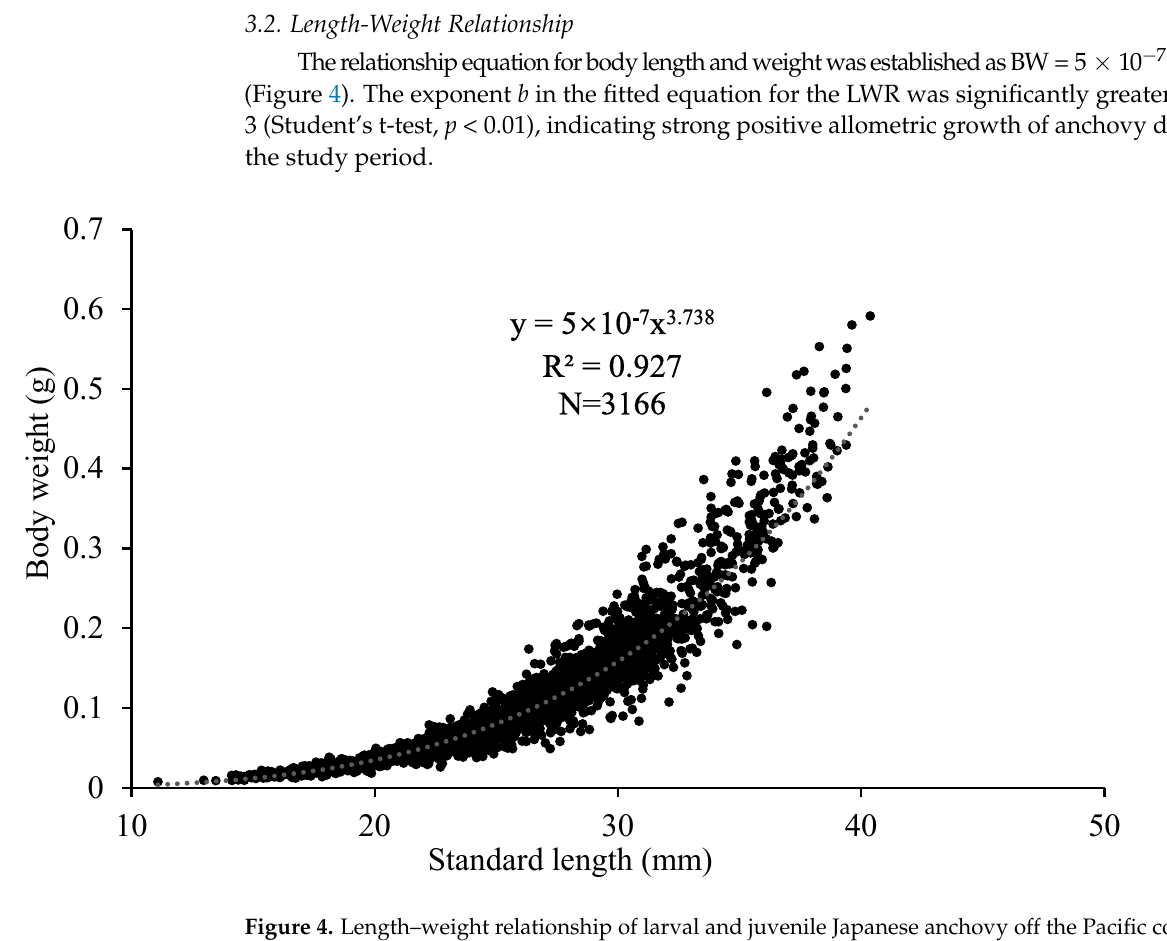
Table 2. The parameter estimates and comparison of the growth models for larval and